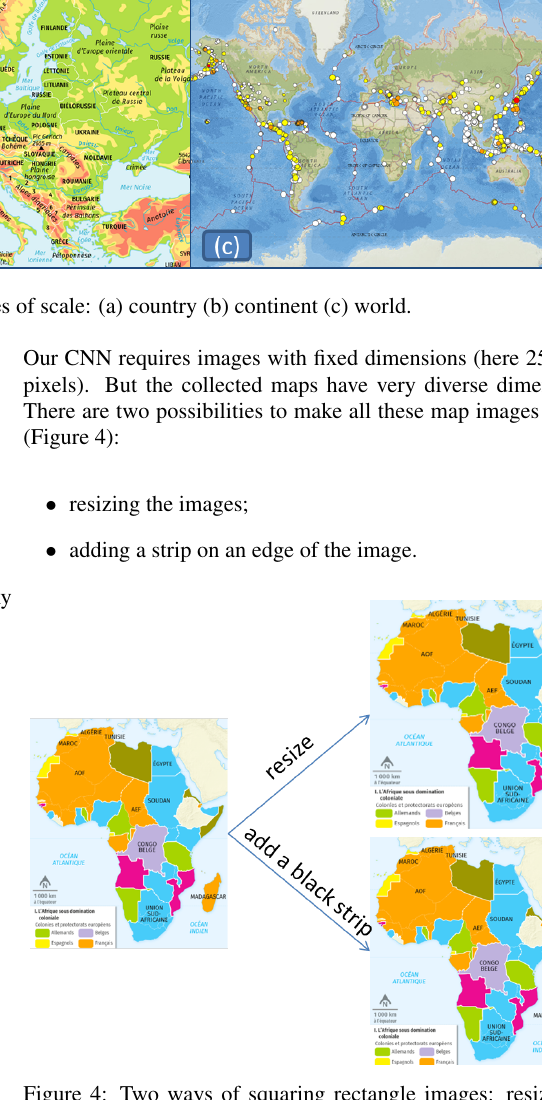
Figure 4: Two ways of squaring rectangle images: resizing or adding a strip (black here) on an edge of the